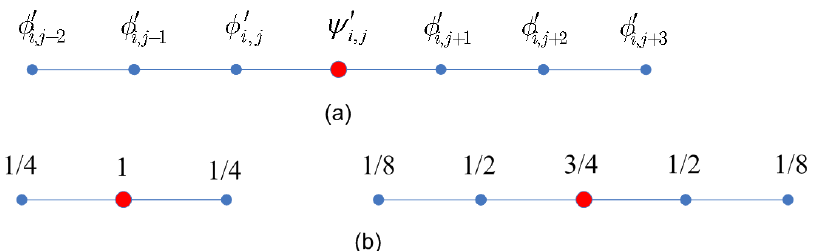
Figure 6. (a) Constructing wavelets as linear combination of lazy wavelets and scaling functions in circular layers; (b) Discrete subdivision masks of basis functions in circular layers (lazy wavelets and scaling